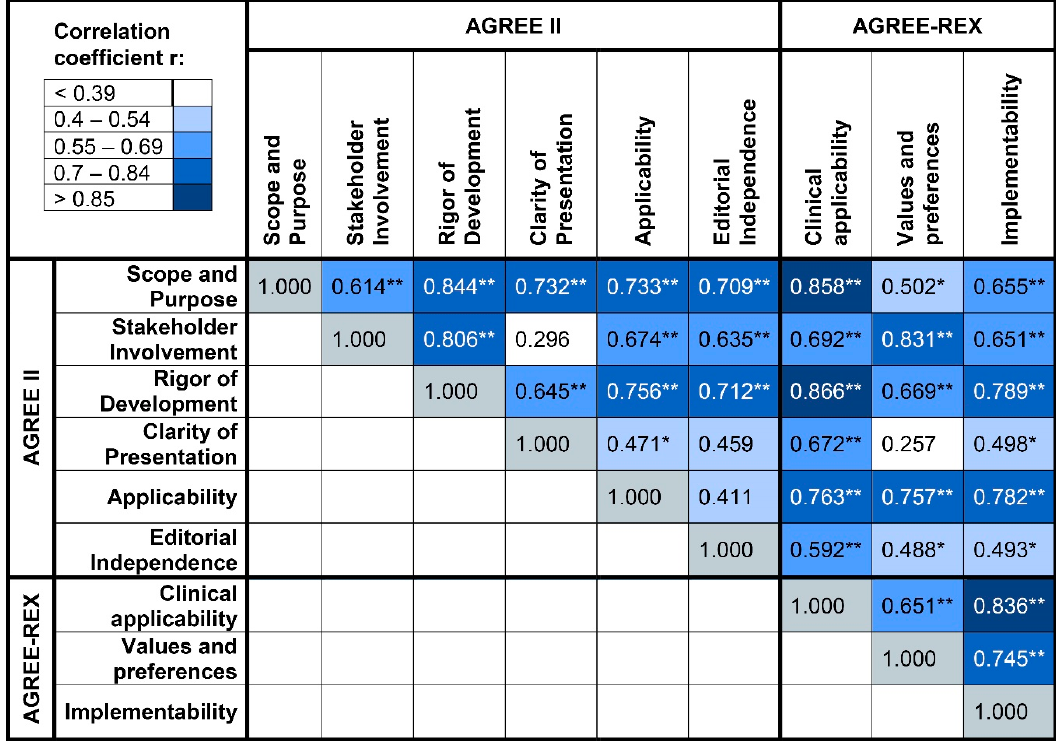
Figure 3. Correlations among the AGREE II and AGREE-REX domains. *: p < 0.05, **: p < 0.01.